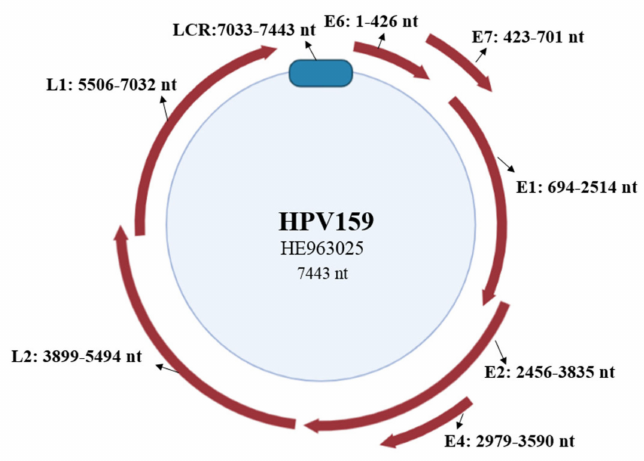
Figure 1. HPV159 genome organization. The positions of viral genes (E6, E7, E1, E4, E2, L2, and L1) and the non-coding long-control region (LCR) are marked with red arrows and a blue rounded rectangle,